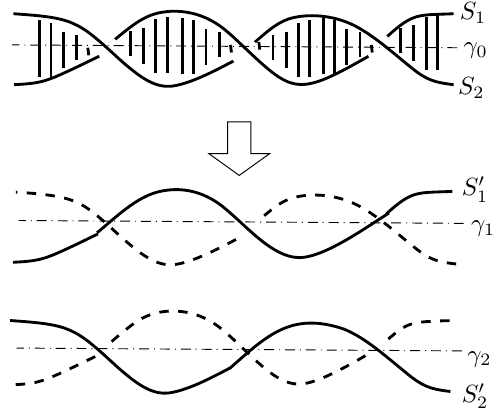
Fig. 8. A topological model of the semi-conservative